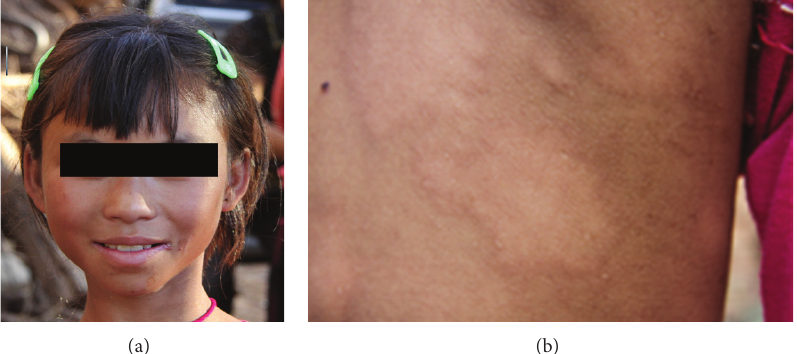
F 2: Physical presentation of leprosy in household contact C13. is 12-year-old female presented with elongated punched out lesions on her back (photograph taken in October 2009).